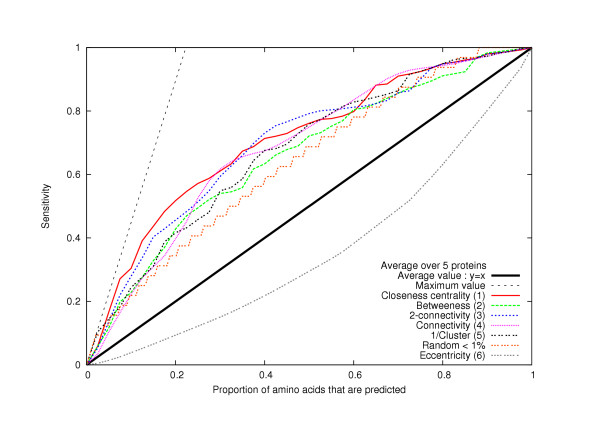
Comparison of 6 different network-based methods for essential amino acids prediction. For each method (Methods 1–6 and "Random <1%") the abscissa x is the proportion of amino acids predicted (by the appropriate centrality measurement) and y is the proportion of essential amino acids predicted (i.e. sensitivity). For example, x = 0.2 means that we select 20% of the amino acids. If we consider the closeness centrality, it means that we select 20% of the amino acids that have the largest closeness centrality. We can notice in this case that we select around 38% of the essential amino acids. The slide of the "Maximum value" curve is the proportion of amino acids that are essential. All the curves have to be under this curve. The better a method is, the closer to the "Maximum value" its associated curve is. A method is better than random if its curve is over the "Average value: y = x" curve. A method is worse than random if its curve is under the "Average value: y = x" curve. The calculations (of the curves 1–6) are made as an average over the five networks representing HIV-1 protease, TEM1 beta-lactamase, T4 lysozyme, Barnase and bacteriophage f1 gene V protein. The curve "Random <1%" only depends on the average number of amino acids of the proteins. There is a probability less than 1% that a random selection of the amino acids will produce a curve over the "Random <1%" curve.